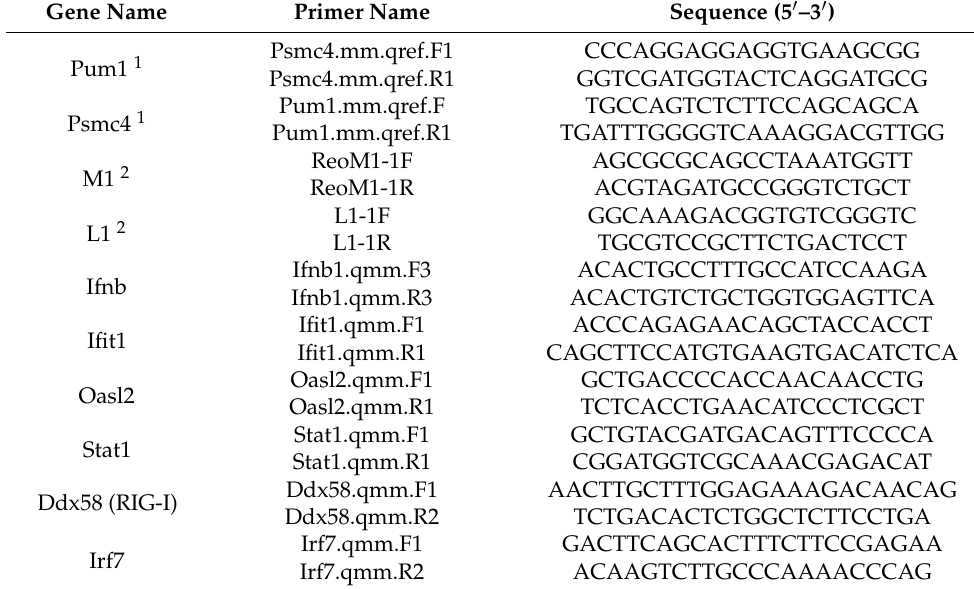
Table 2. Primers used in this